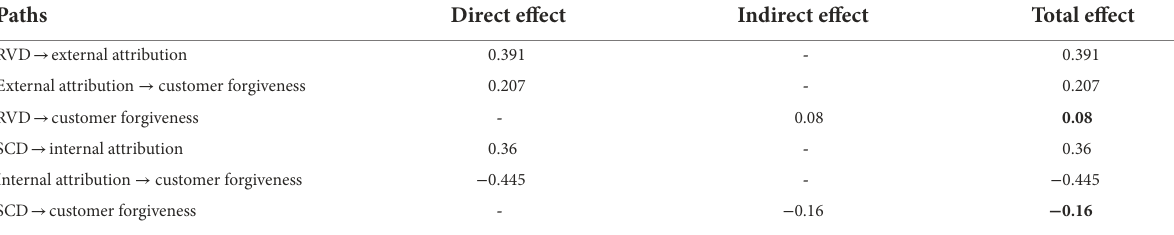
TABLE 6 Direct and indirect effects.